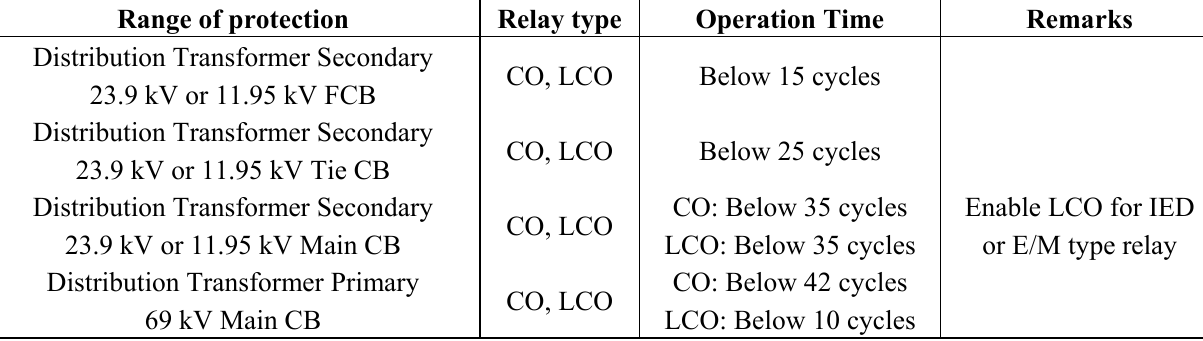
Table 2. Secondary substation distribution transformer feeder protective relay setting